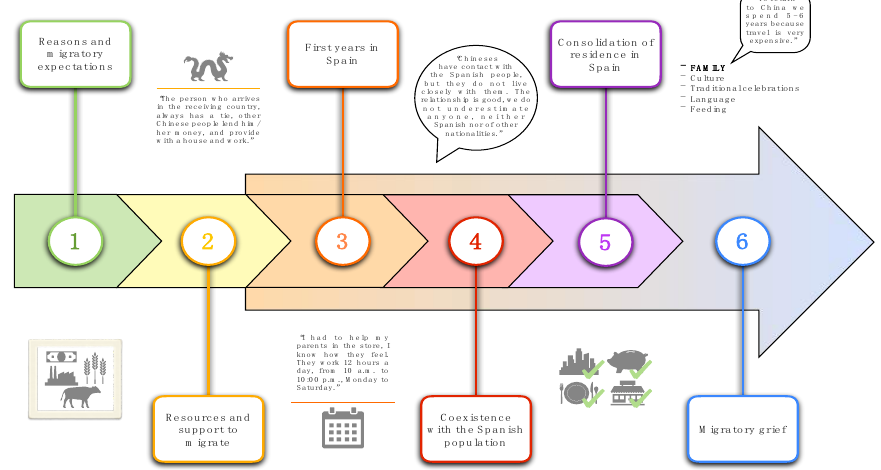
Figure 1. Milestones associated with the Chinese migratory